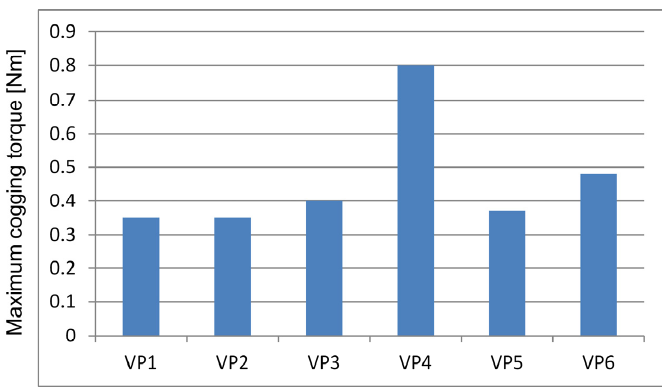
Energies 2023 , 16 , x FOR PEER REVIEW Figure 4. Cogging torque comparison . Figure 4. Cogging torque comparison.